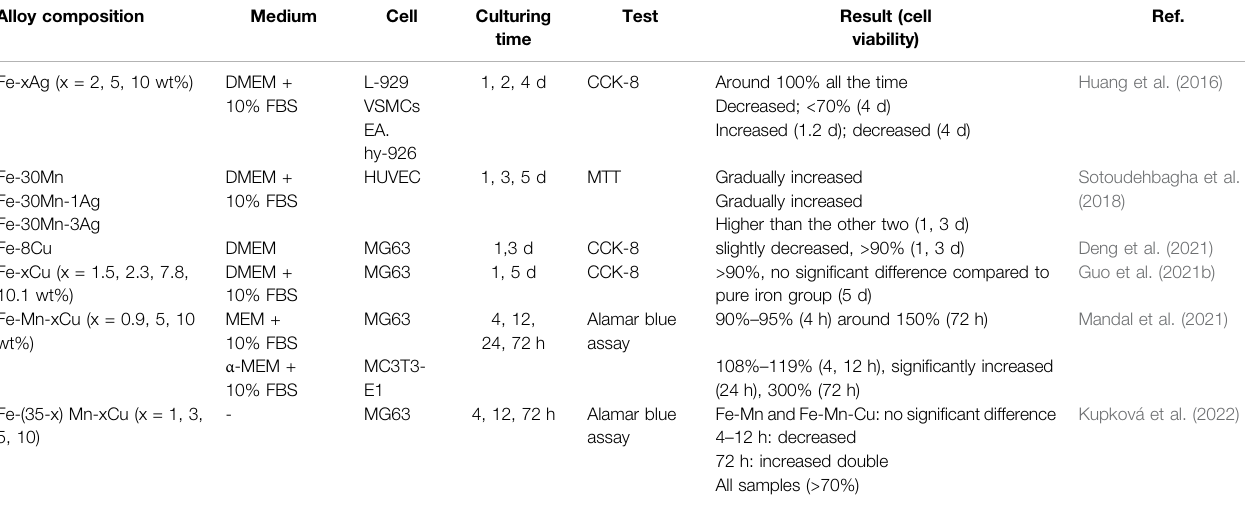
TABLE 9 | In vitro biocompatibility of Fe-based alloys with antibacterial properties as orthopedic implants. Alloy